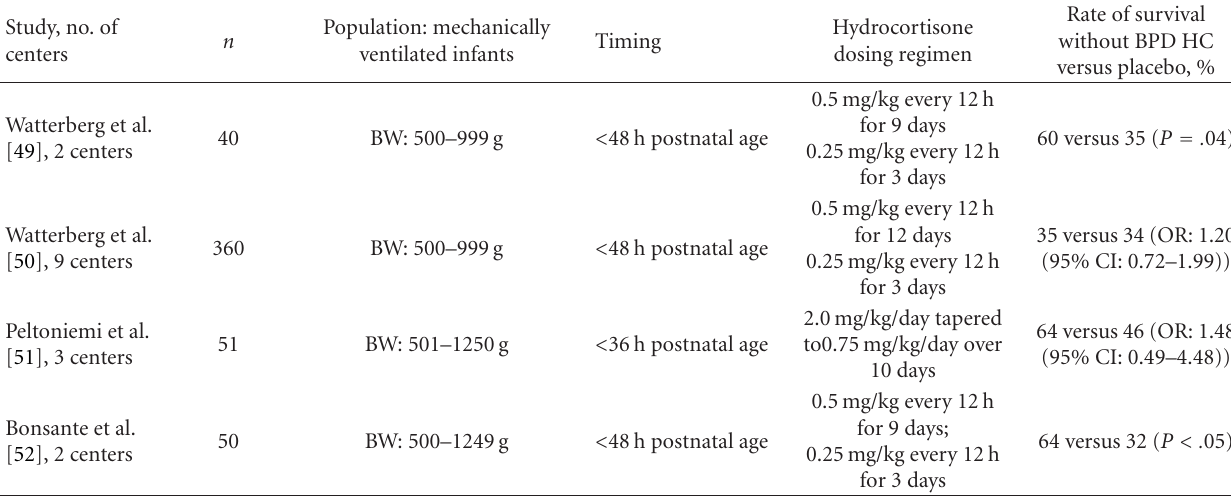
Table 3: RCTs of early hydrocortisone to prevent